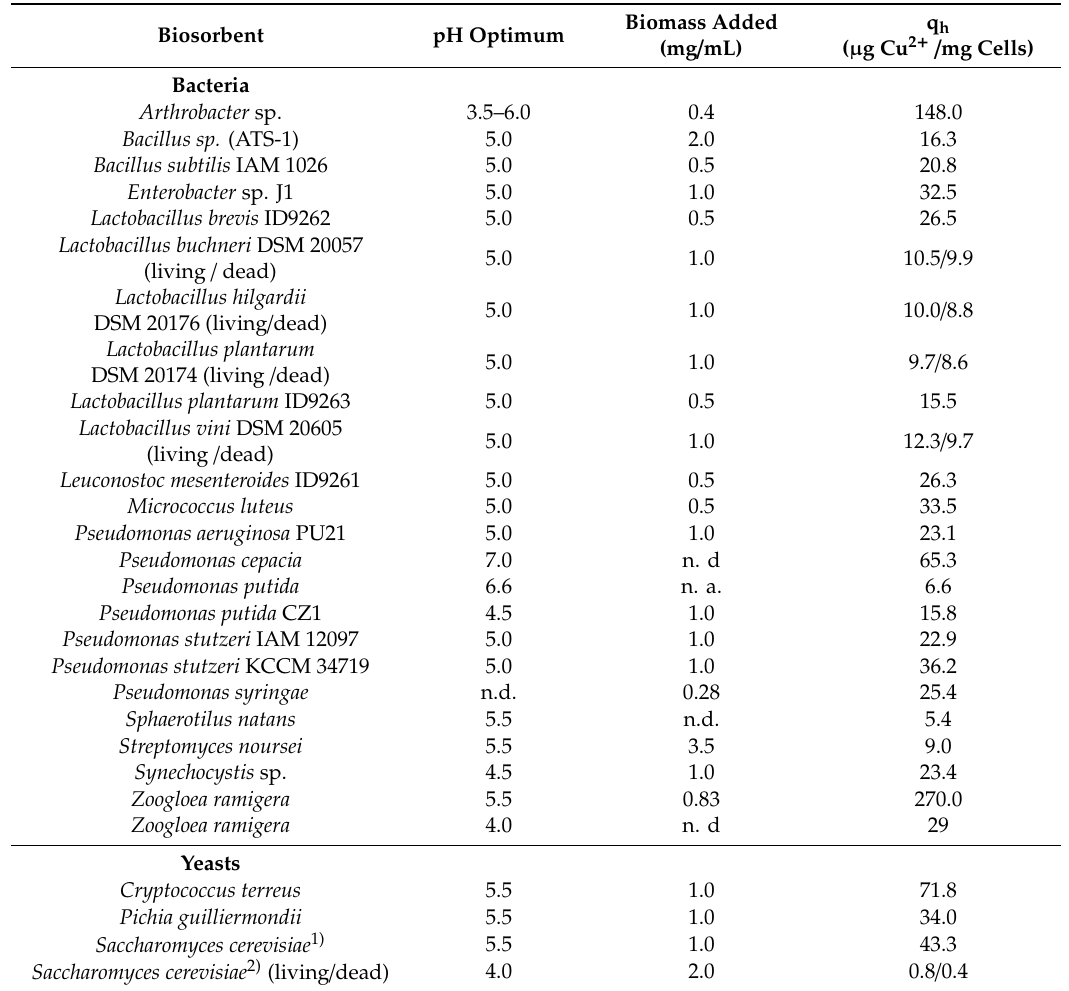
Table 2. Compilation of biosorbent materials and their maximum specific copper binding capacity (qh)